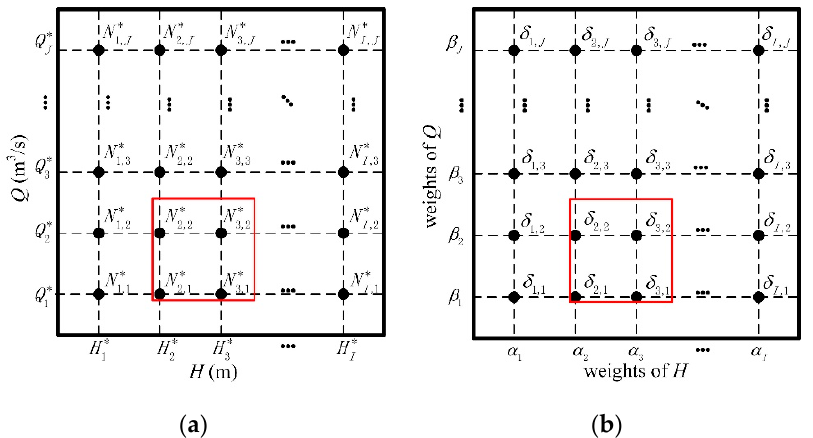
Figure 3. Linearization sketch of the hydropower output function. ( a ) Discretization of the hydropower output function; ( b ) weights of discretized values.